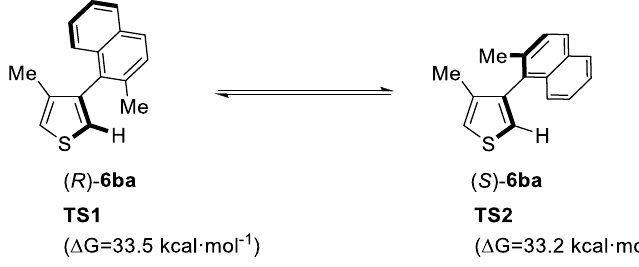
Figure 1. Rotation energy of 6ba calculated at B3LYP/6-31G(d) level. Reproduced from Reference [60].